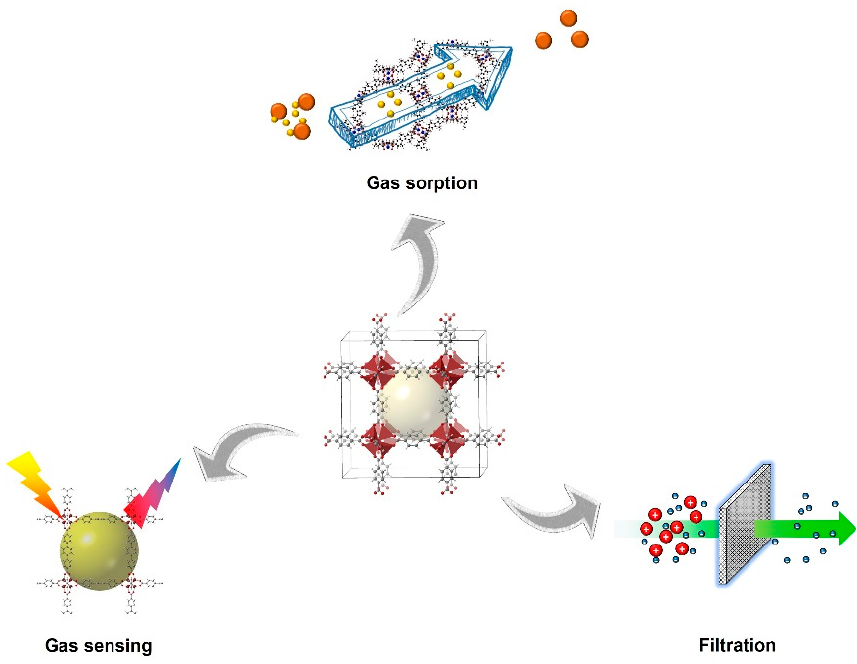
Table 1. Abridgment of some stable MOFs